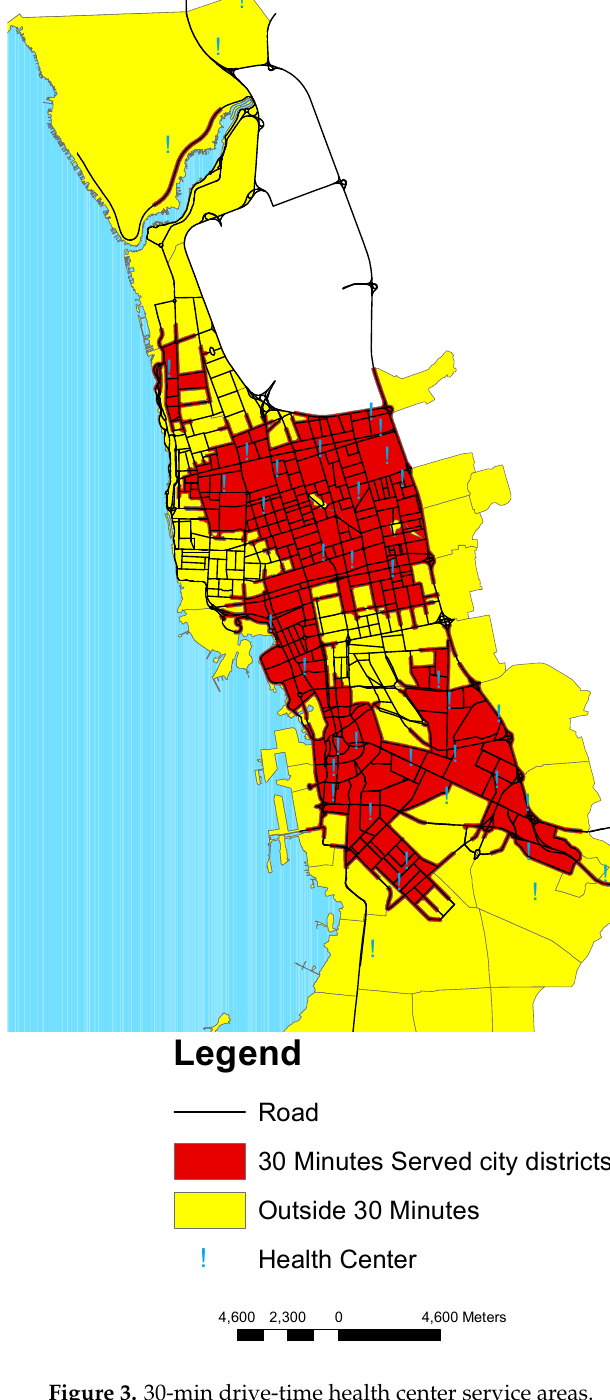
Figure 3. 30-min drive-time health center service areas.